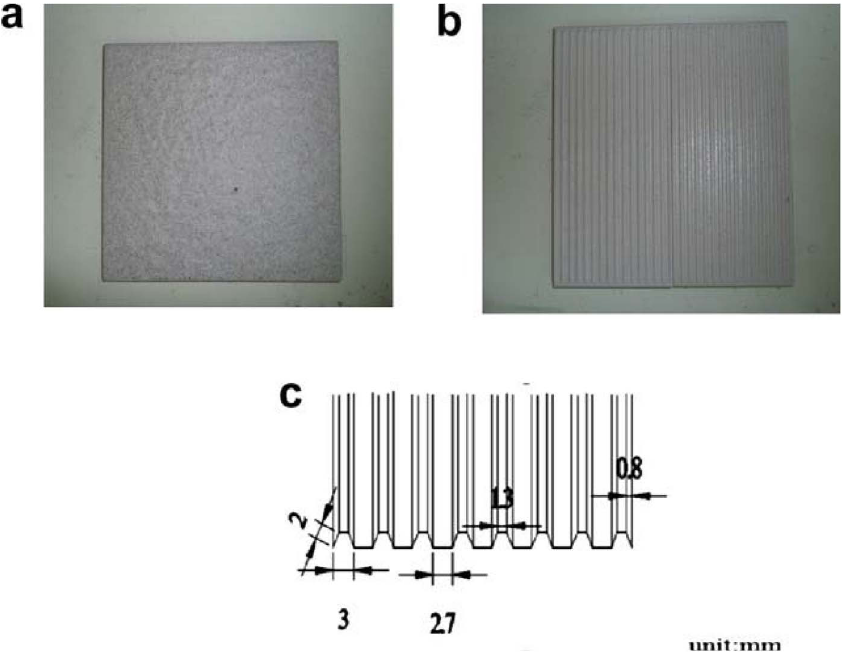
Figure 2. Floor: (a) flat ceramic floor; (b) unglazed ceramic floor with molded trapezoid groove design; (c) dimensions of the groove.